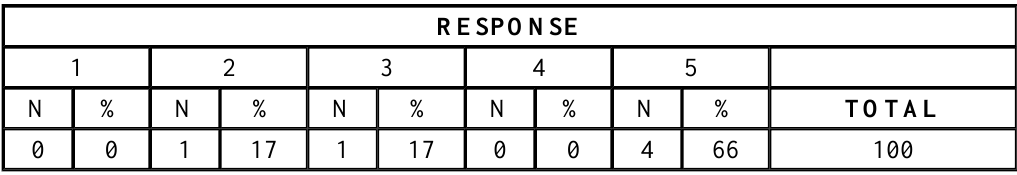
Table 7 Estimated budgetary spend per organization on BI applications (data warehouse and middleware